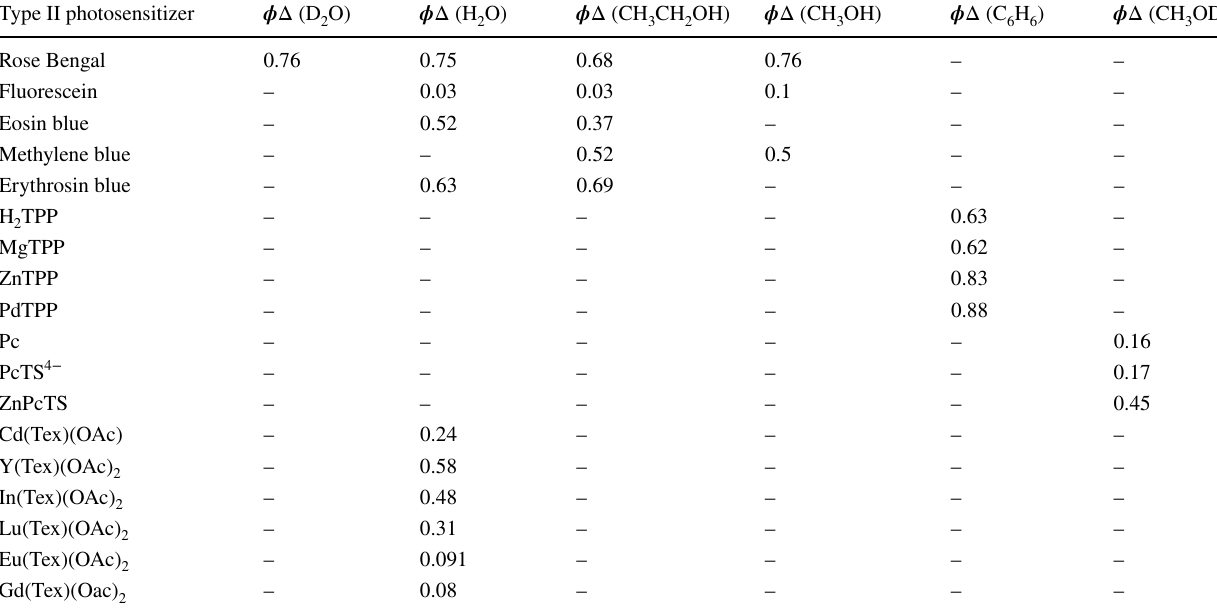
Table 1 Different photosensitizers and their singlet oxygen generation quantum efficiencies ( ϕ Δ) as-obtained from the literature [52–60] Type II